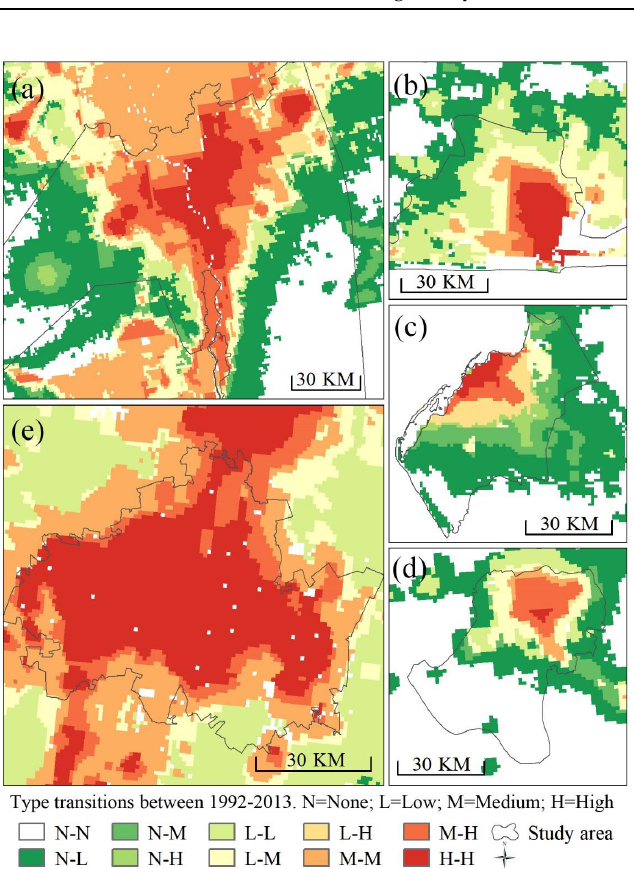
Figure 9. Spatial transitions of different nighttime light types in several African cities between 1992 and 2013: ( a ) Cairo; ( b ) Lagos; ( c ) Luanda; ( d ) Addis Ababa; ( e ) Johannesburg.